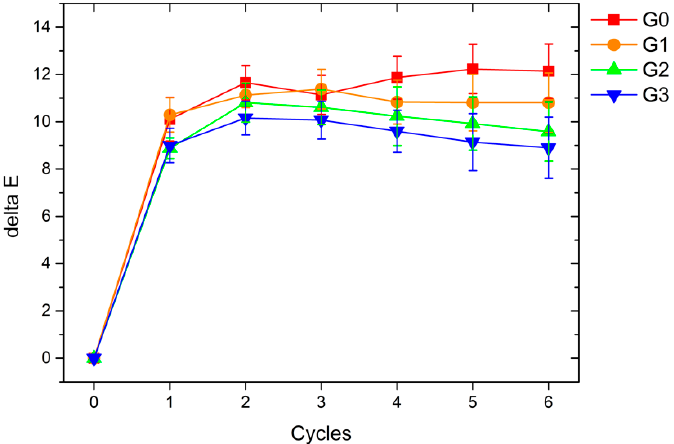
Figure 12. Color variation of the samples during the accelerated degradation test.